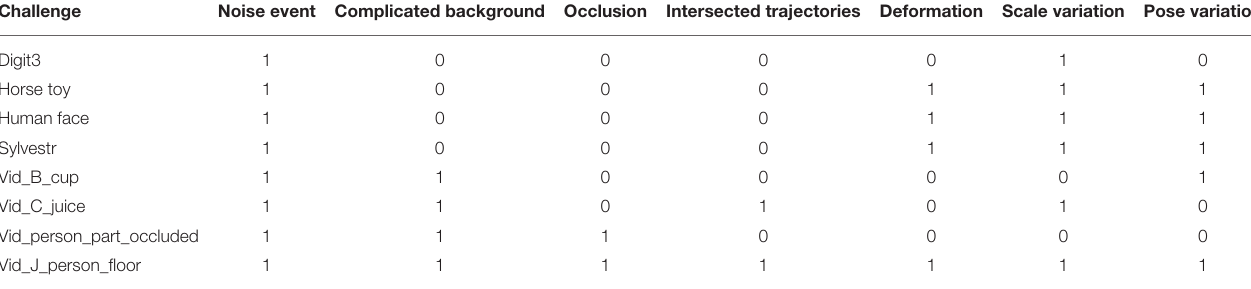
TABLE 1 | Challenges of each recording.